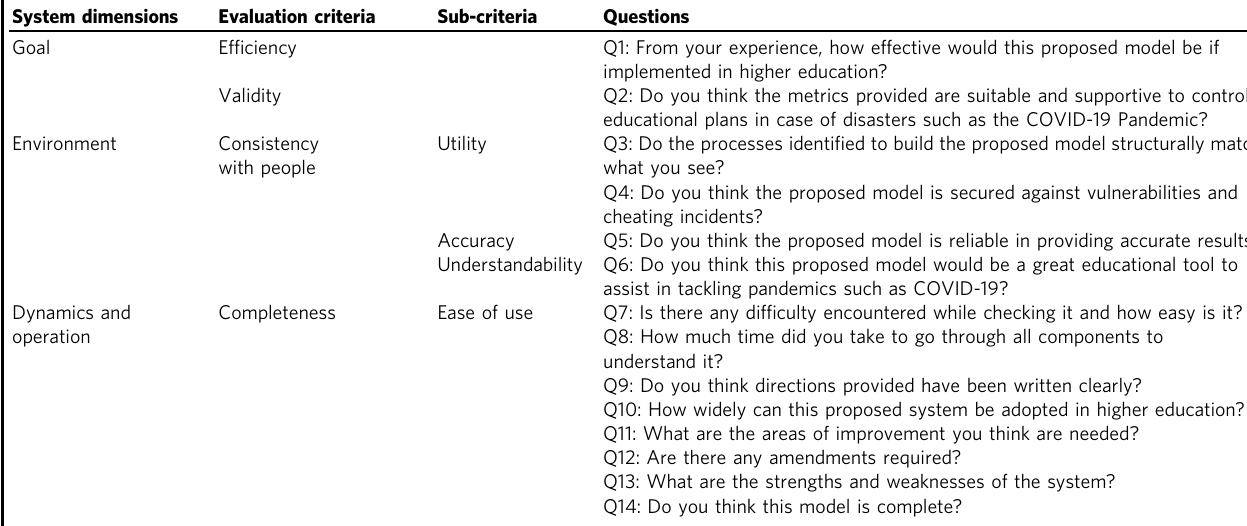
Table 1 Expert evaluation criteria. System